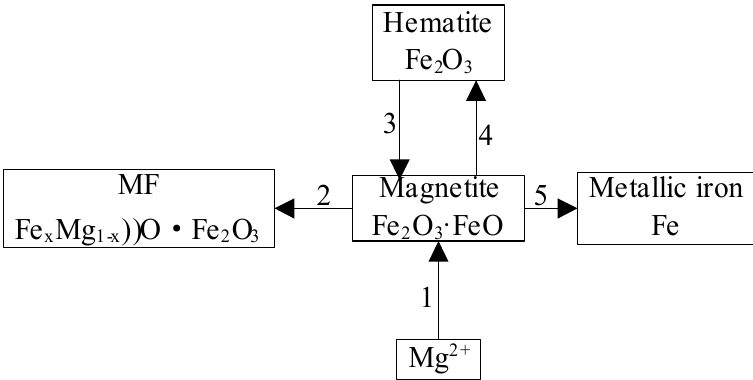
Figure 22. Schematic overview of the influence of MgO content on mineral compositions:(1) Mg 2 + diffusion into magnetite lattice; (2) formation of MF; (3) reduction of hematite to magnetite; (4) reoxidation of magnetite to hematite during cooling; (5) reduction of magnetite to metallic iron.